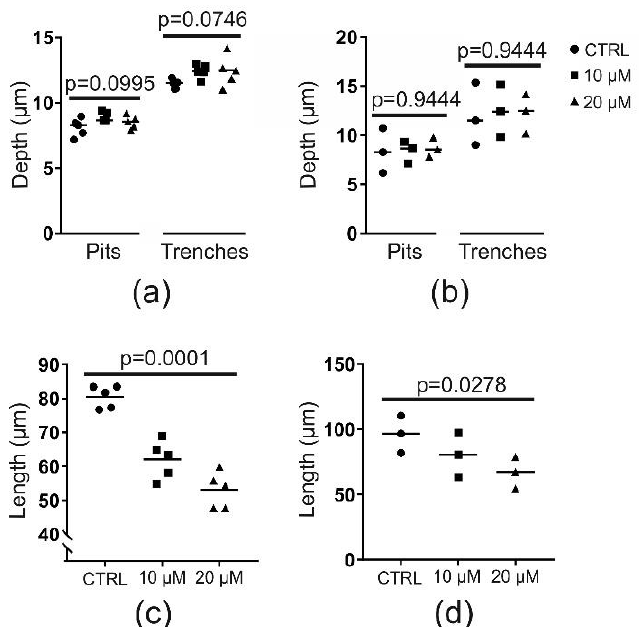
Figure 2. Chloroquine, at 10 or 20 µM, does not reduce the demineralization depth of pits or trenches, but significantly reduces the length of trenches. ( a ) Representative analysis of depth from one resorption experiment (using OCs from a single donor) subdivided into pits and trenches. Each point represents the mean of 100 analyzed events per bone slice ( n = 5 bone slices per condition). Statistics: Kruskal–Wallis test. ( b ) Median depth of pits and trenches in three different experiments with OCs from different donors. These medians were determined from five bone slices per condition as shown in (a). Statistics: Friedmann test. ( c ) Representative analysis of trench length from one resorption experiment (using OCs from a single donor); each point represents the mean of 100 events per bone slice ( n = 5 bone slices per condition). Statistics: Kruskal–Wallis test. ( d ) Median length of trenches in three different experiments with OCs from different donors. These medians were determined from five bone slices per condition as shown in (c). Statistics: Friedmann test.